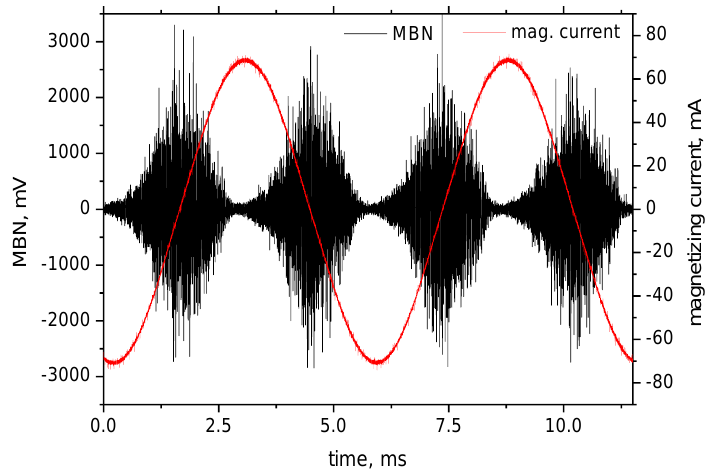
0 . 02 . 55 . 07 . 510 . 0 Figure 10. MBN signal, ε = 2.5%, magnetising voltage 5V, magnetising angle 0° (RD). Figure 10. MBN signal, ε = 2.5%, magnetising voltage 5V, magnetising angle 0 ◦ (RD). Figure 10. MBN signal, ε = 2.5%, magnetising voltage 5V, magnetising angle 0° (RD).